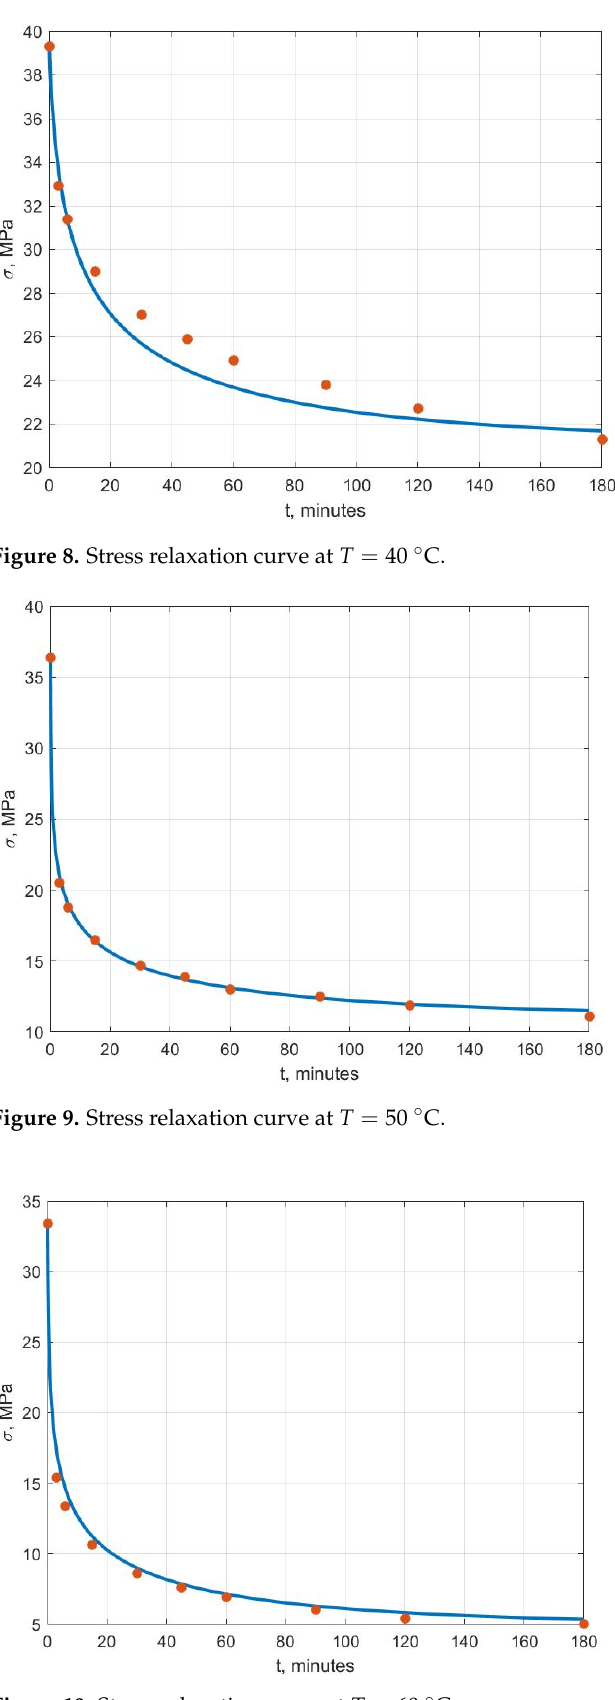
Figure 7. Stress relaxation curve at 𝑇 = 30 °C .